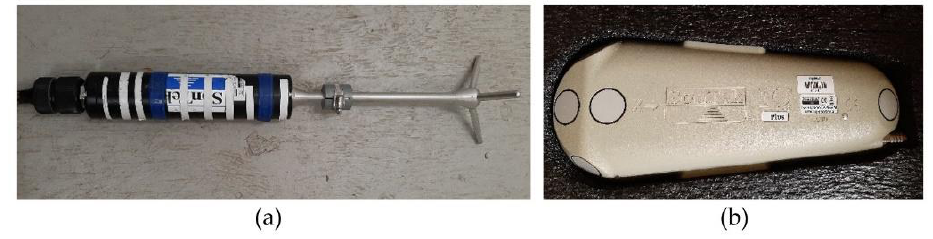
Figure2. ( a ) ADV used in this study, ( b ) Sontek